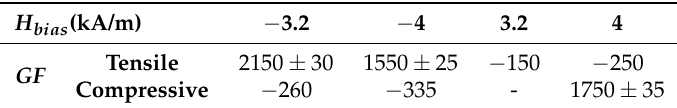
Table 2. Gauge factors GF measured from the strain loops in Figure 6. The positive and negative signs of the gauge factors stand for the resistance increase and decrease in the strain